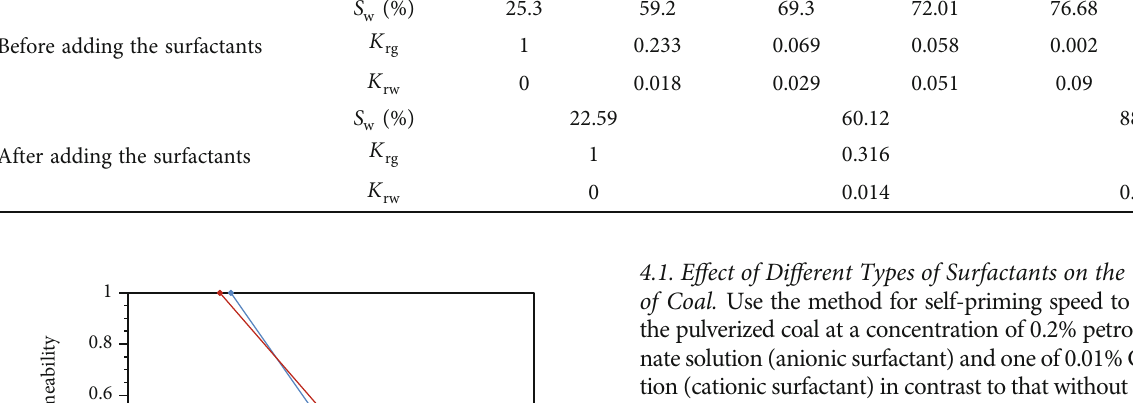
Table 5: Experimental results of the coal ’ s gas-water relative permeability before and after adding the surfactants. Before adding the surfactants